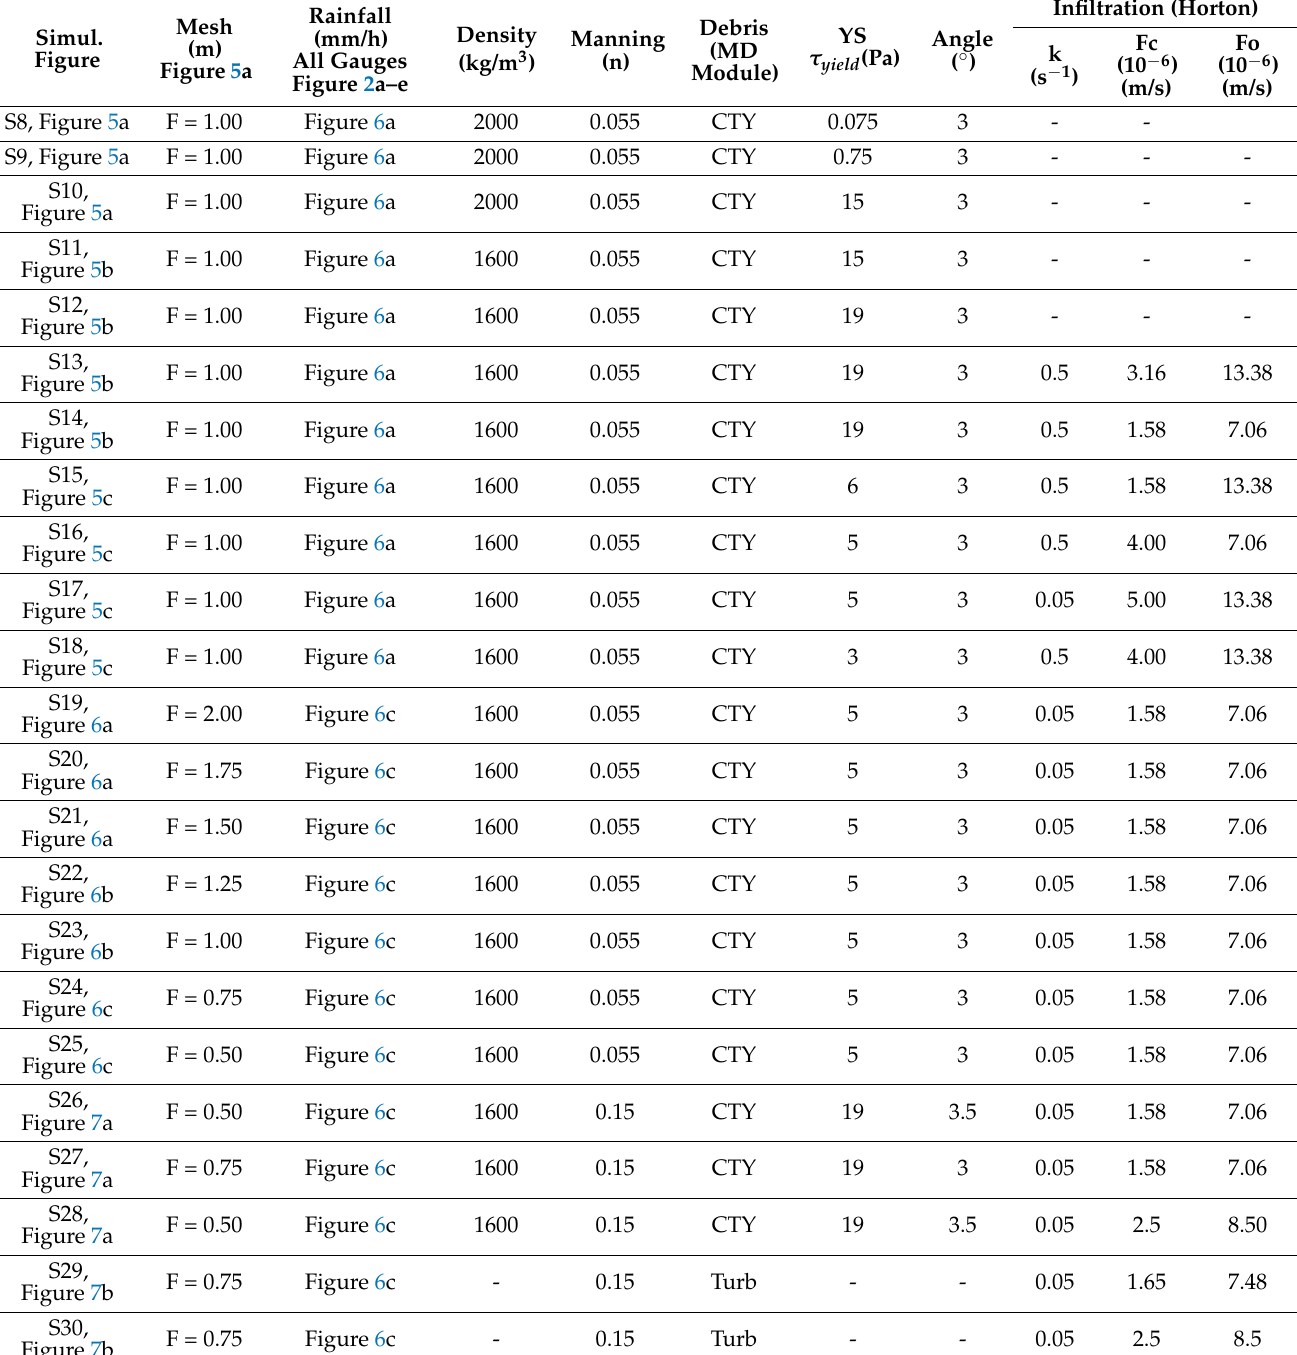
Table 2. Summary description of the main numerical parametric simulations resulting from the inclusion of the 5 rainfall gauges and also the Horton’s infiltration model; F: factor that multiples the average cell width; Turb: Turbulent; Fo and Fc: the initial and final infiltration capacities (m/s); k: the rate of decrease in the capacity (s − 1 ). Simul.